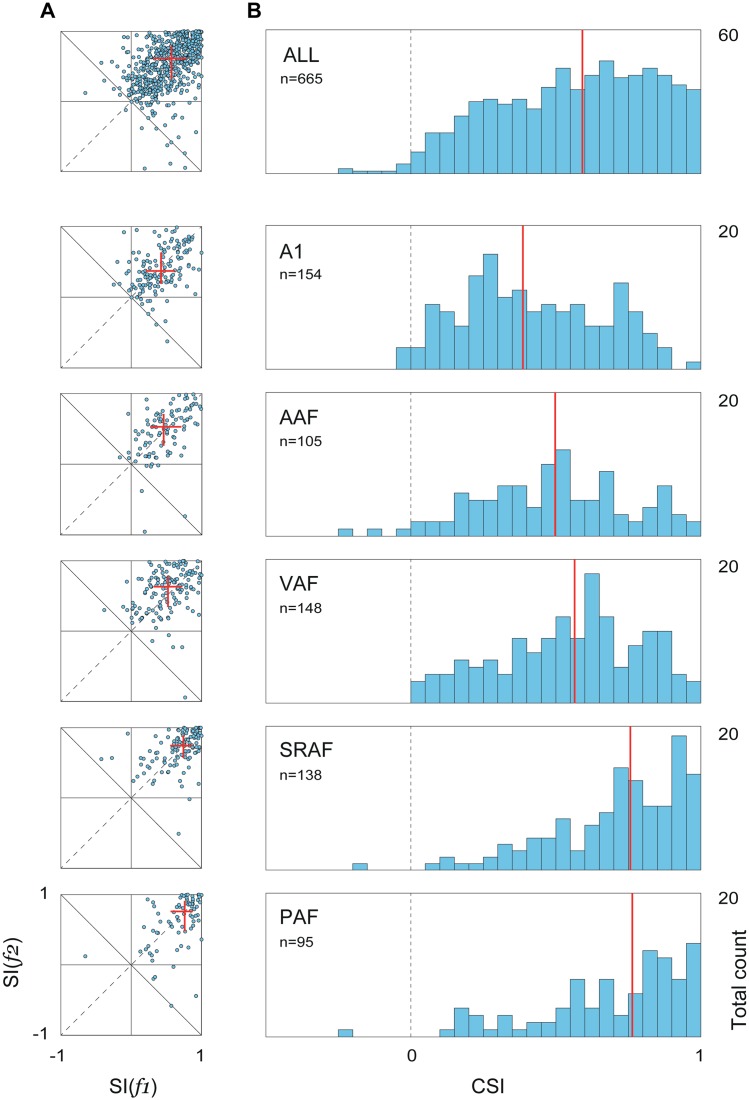
Distribution of SSA indexes within each field.
A. Distribution of frequency-specific SSA indexes for the whole population and for each field separately. Red lines represent median and inter-quartile range for SI(f
1) and SI(f
2), showing a progressive increase in SSA from primary to nonprimary fields. B. Corresponding distributions of the CSI. In the primary fields, distributions are symmetrical and centered in medium-CSI values, but in the nonprimary fields, CSI distributions are sharply skewed to extreme levels of SSA. Red lines show distribution medians, which were statistically different between every primary and nonprimary field (see text). Underlying data for this figure can be found in S2 Data.